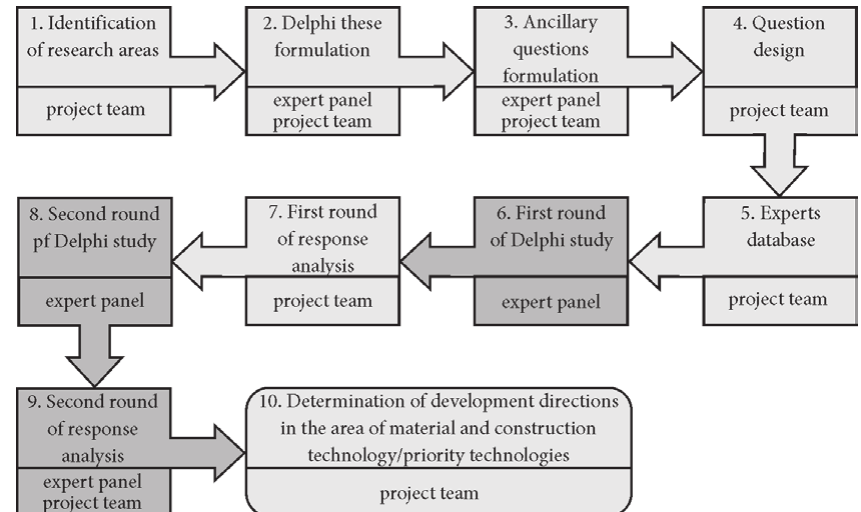
Fig. 1. Operationalization of Delphi methodology designed for the